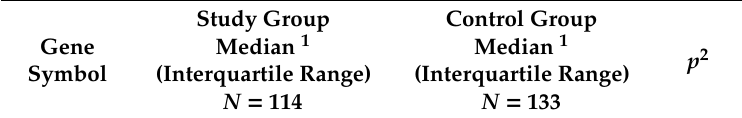
Table 3. Comparison of the concentration of activators and inhibitors of NFκB between the study and control group.